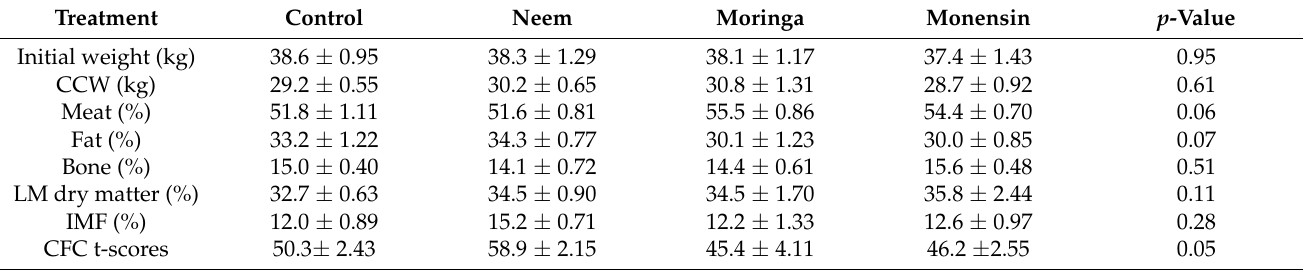
Neem Moringa Monensin p -Value